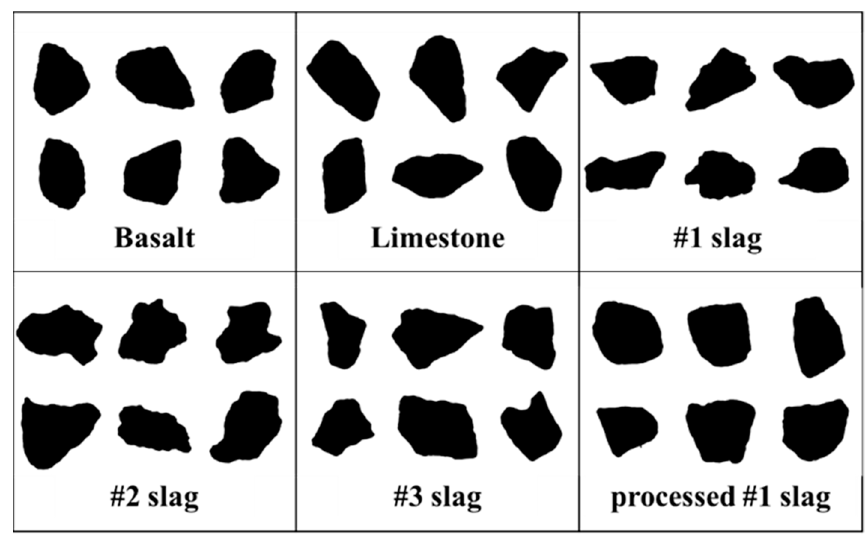
Figure 7. Parts of the profile image of different types aggregate particles.